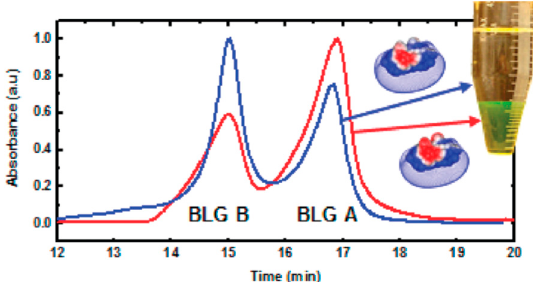
Figure 10. Ion exchange chromatography analysis of BLG-A and -B composition in different phases after PE coacervation of native BLG (A/B = 1:1). Red line, coacervate; blue line, supernatant. Figure 10 was taken from the work of [32].